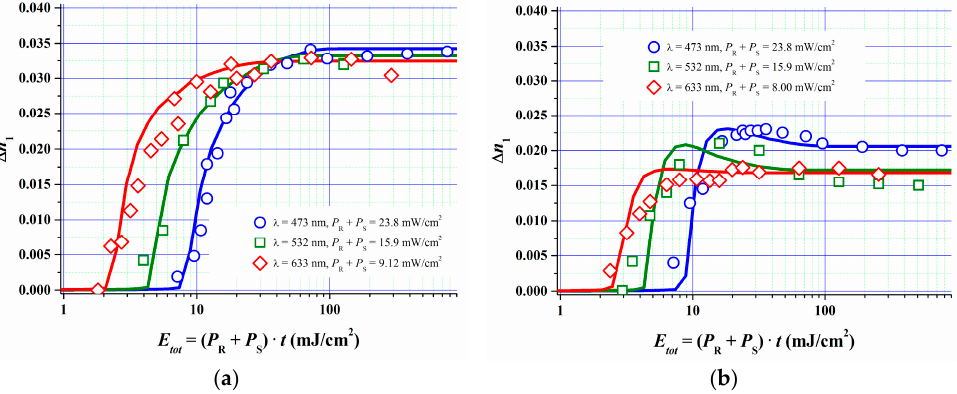
Figure 12. Experimental and simulated dosage-response curves for RGB sensitive Bayfol ® HX film; ( a ) reflection geometry data; ( b ) transmission geometry data [51].